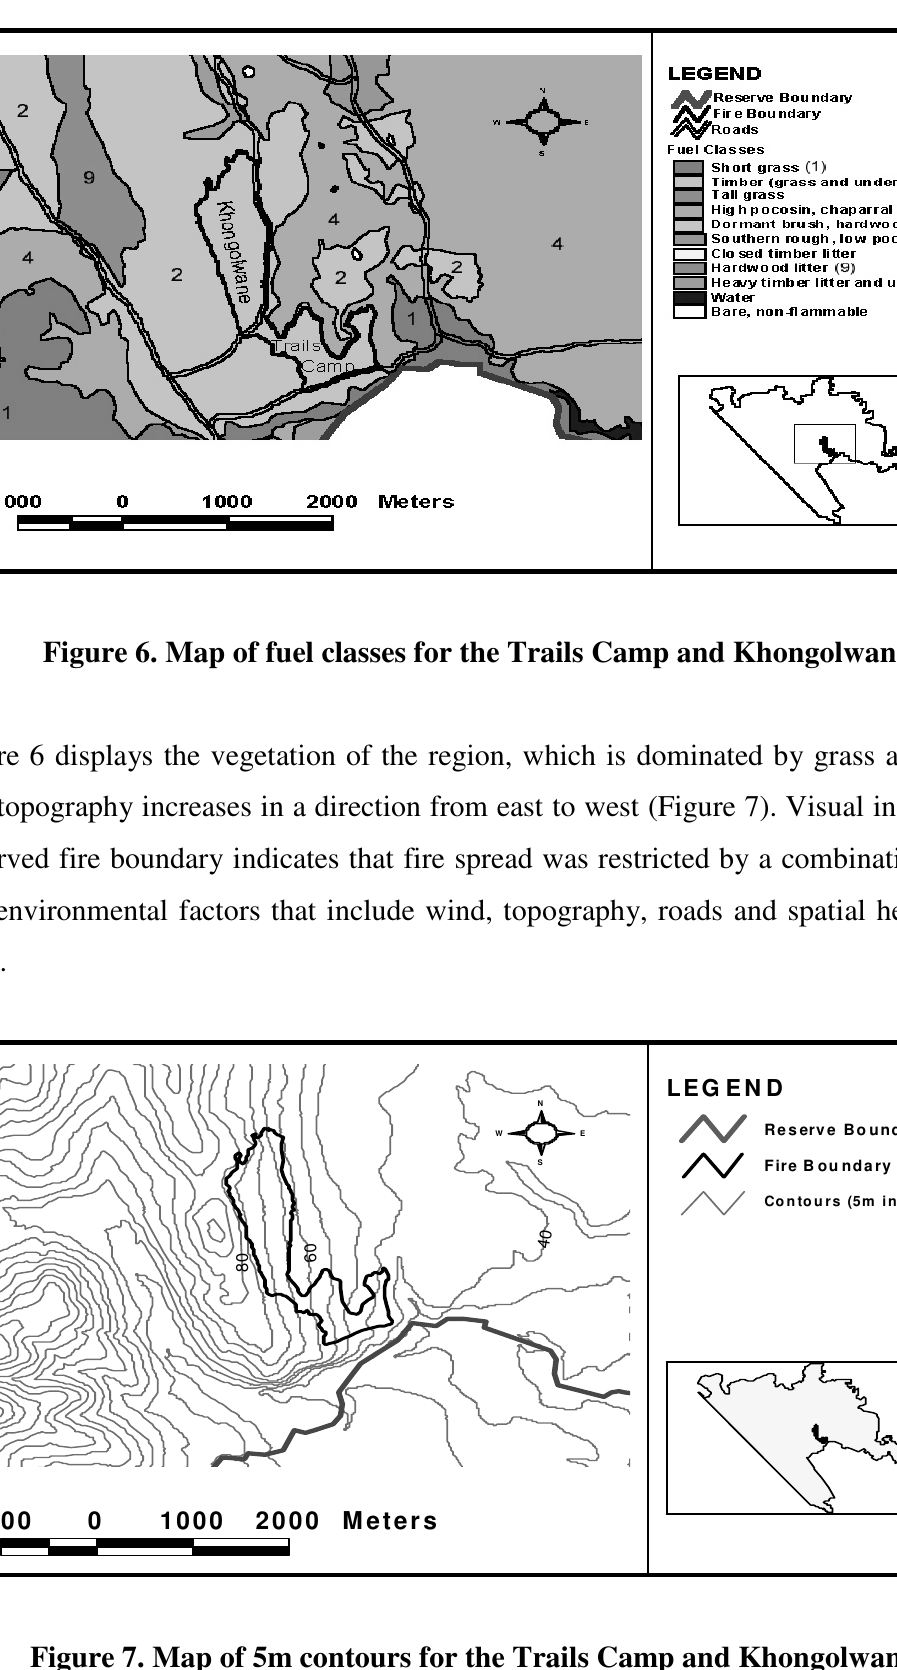
Figure 7. Map of 5m contours for the Trails Camp and Khongolwane